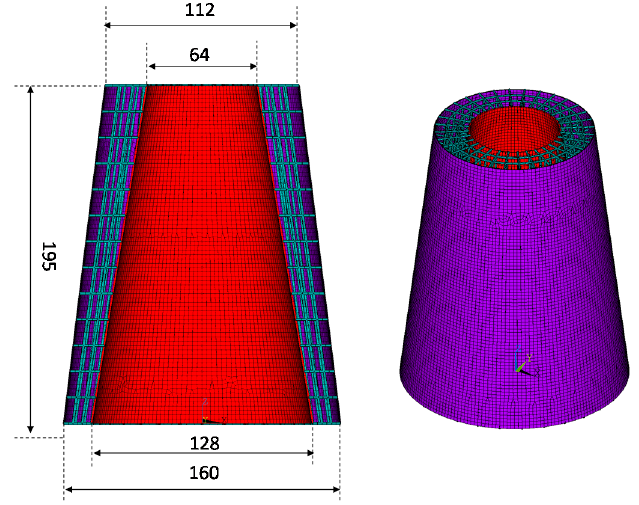
Figure 10. Test case 1—FE model.